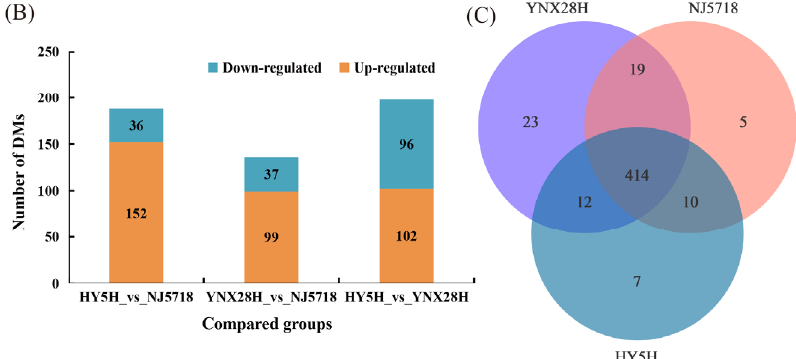
Figure 2. Sample reproducibility and metabolite analysis. ( A ) Correlation heatmap of three semi- glutinous japonica rice grain samples. The right and inferior sides in the figure are the sample names. ( B ) Pairwise comparison of DMs. ( C ) Venn distribution of metabolites. HY5H, Hongyang 5 hao; YNX28H, Yangnongxiang 28; NJ5718, Nanjing 5718.